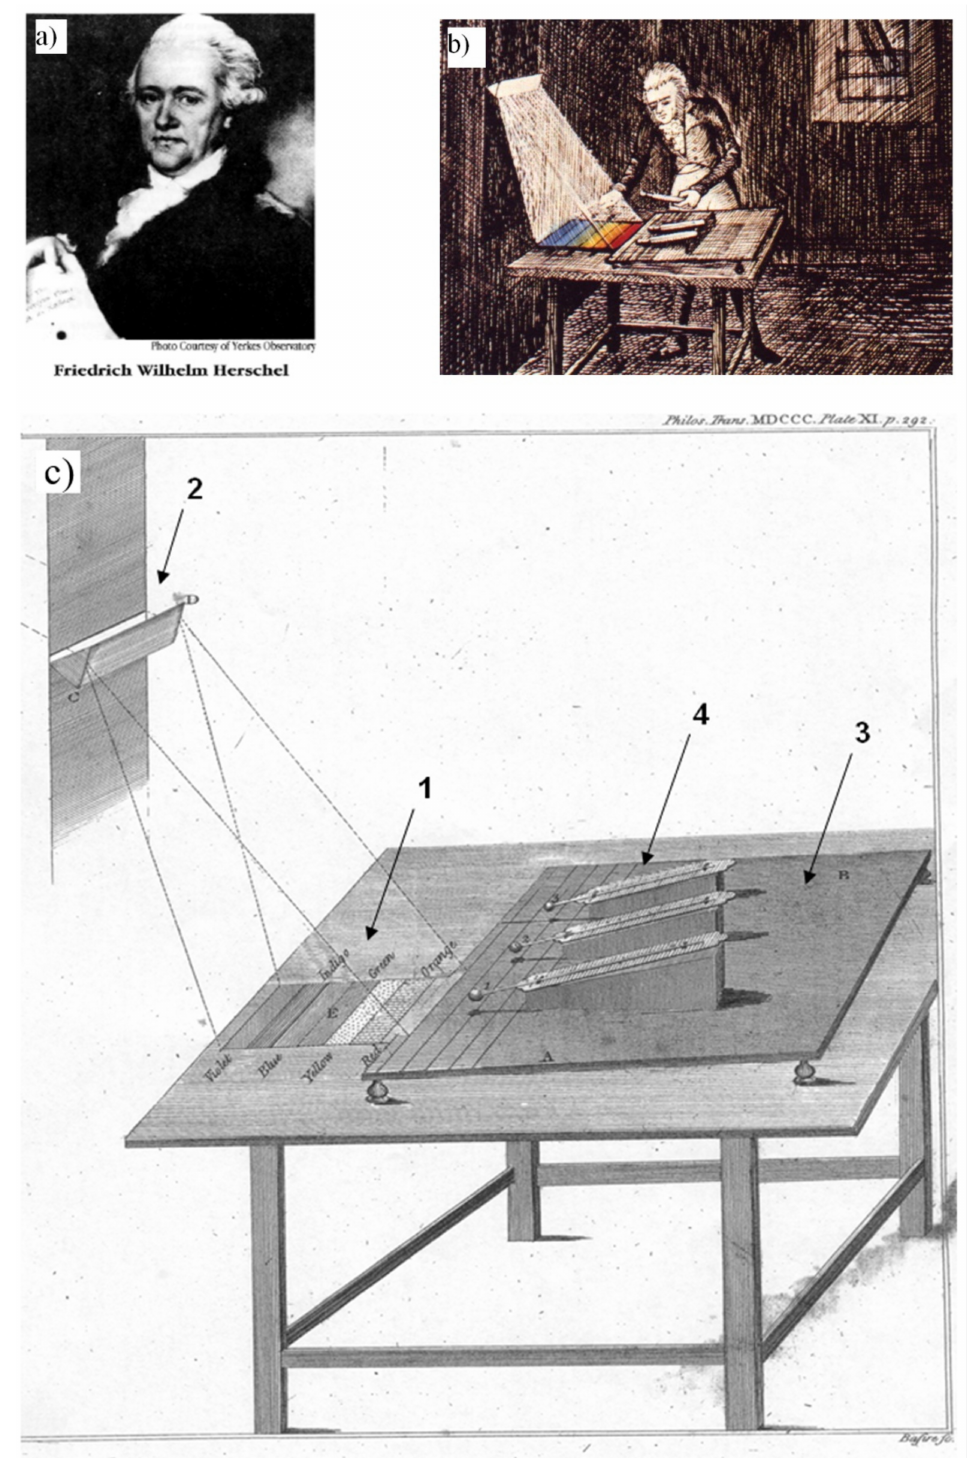
Figure 1. ( a ) Photograph of Dr Frederick William Herschel and ( b , c ) drawings illustrating his experience connected with the discovery of infrared radiation: 1. spectrum of solar radiation (colours from left, according to Herschel’s markings: violet, indigo, blue, green, yellow, orange, red), 2. prism in the window through which the solar radiation falls (a thick dark green curtain was installed in the window), 3. measuring table, 4. mercury thermometers numbered: 1,2,3 (from left to right); the drawing was made by the graphic artist James Basire [6–8]; ( c ) is an original drawing of the measurement